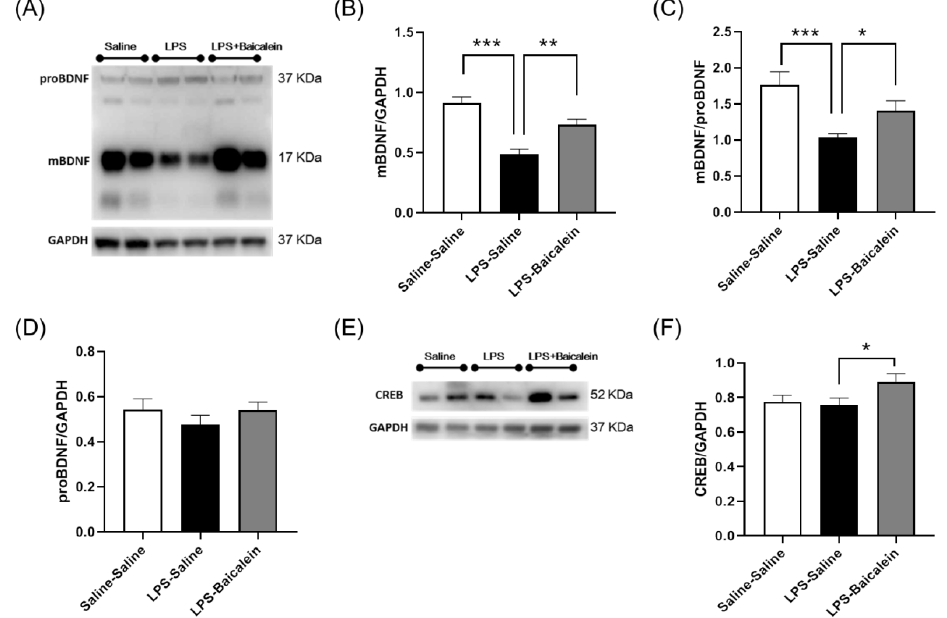
Figure 7. Effect of baicalein on the protein levels of BDNF and CREB in the hippocampi of mice. ( A ) Western blots showing levels of mBDNF and proBDNF. The levels of mBDNF ( B ) and the ratio of mBDNF/proBDNF ( C ) in the hippocampus decreased significantly after the administration of LPS (5 mg/kg, i.p.). Treatment with baicalein (3 mg/kg, i.p.) 1 h following LPS administration could inhibit the reduction. The levels of proBDNF ( D ) did not differ among the groups. ( E ) Western blots showing levels of CREB. Baicalein promoted a significant increase in the expression of CREB protein ( F ), as observed in LPS-Baicalein-treated mice. Data are presented as means ± SEM. ( n = 8) * p < 0.05, ** p < 0.01, *** p < 0.001.